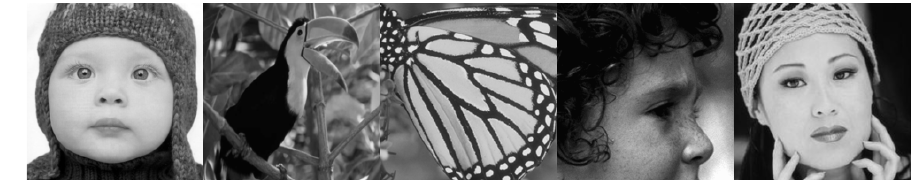
Figure 3. Thumbnails of Set5.